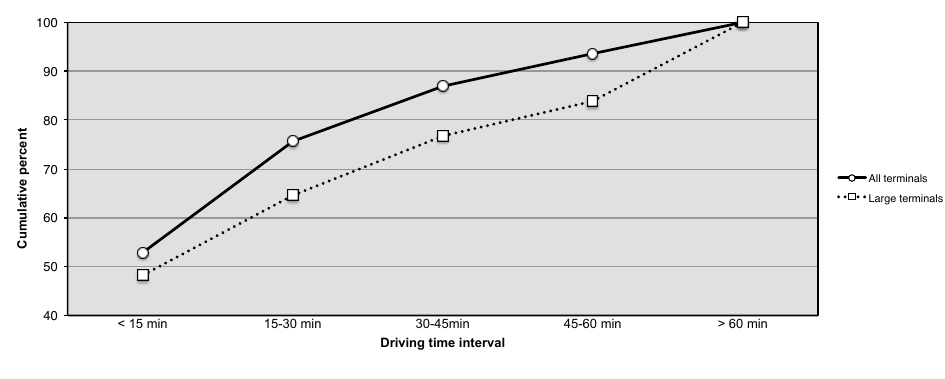
Figure 5: Cumulative share of food industry companies within different driving-time intervals from all terminals and large